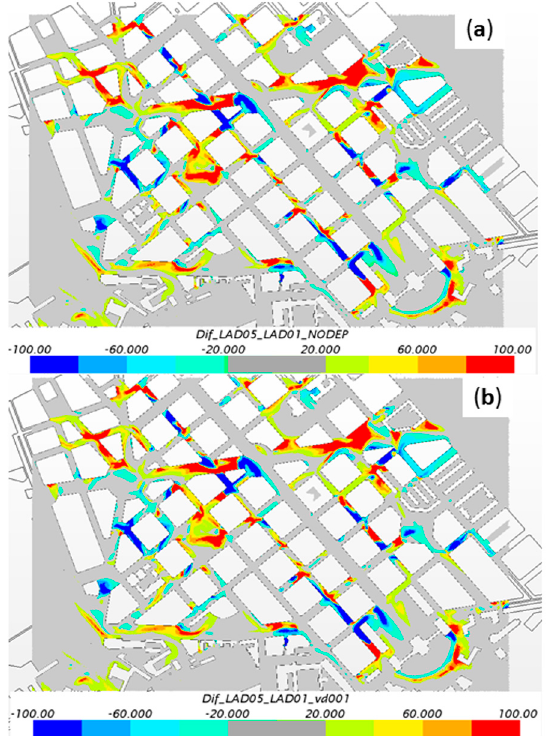
Figure 6. Differences of NO x concentrations between results from: ( a ) Current-2a and Current-1a ( b ) Current-2c and Current-1c. Red indicates that the concentration is higher for evergreen vegetation (LAD = 0.5 m 2 m − 3 , Current-2 cases). Grey indicates similar concentration ( ± 20 µ g m − 3 ).